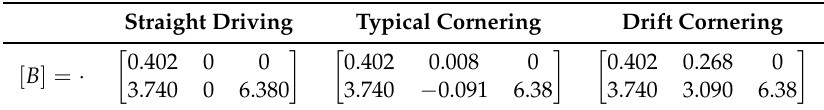
Table 2. Input effects on vehicle dynamics for three driving conditions at 8 m/s forward speed. The reported values were multiplied by a factor 10 3 . Straight Driving Typical